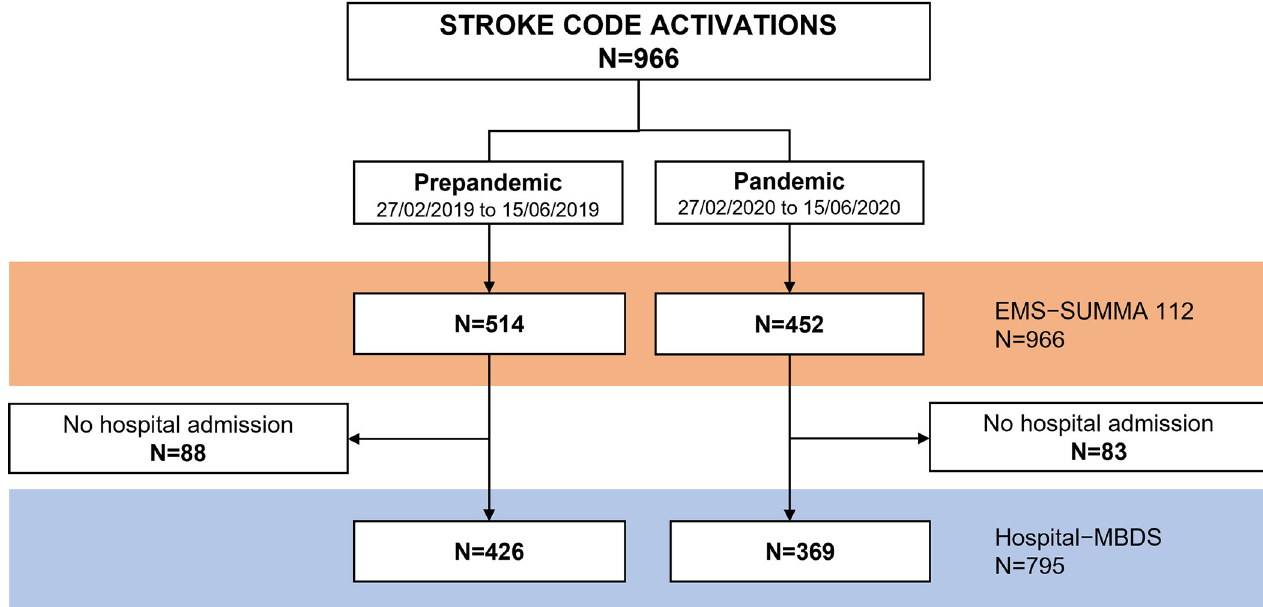
Fig 2. Patient flowchart. SUMMA 112: EMS of Madrid. MBDS: Minimum Basic Dataset.